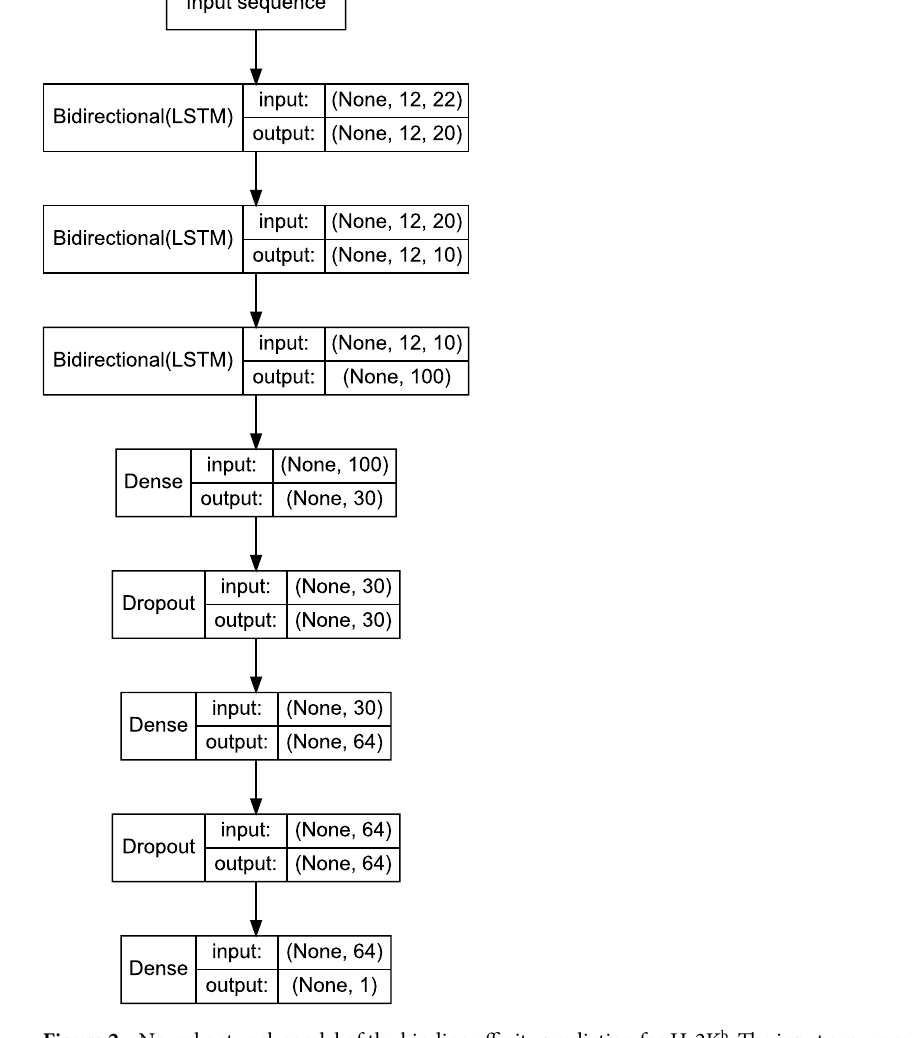
Figure 2. Neural network model of the binding affinity prediction for H-2K b . The input sequence corresponds to a one-hot encoding of a 12 mer peptide sequence extracted from the preprocessing workflow. The number of LSTM units corresponds to the input sequence’s overall length across the three consecutive layers. Following the RNN, two hidden dense units, with alternating dropouts, serve to process an affinity